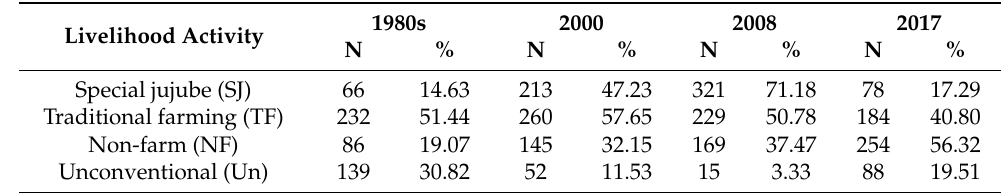
Table A2. Number and proportion of households by participation in different livelihood activities from 1980s to 2017, among 451 surveyed rural households in the Jia County.